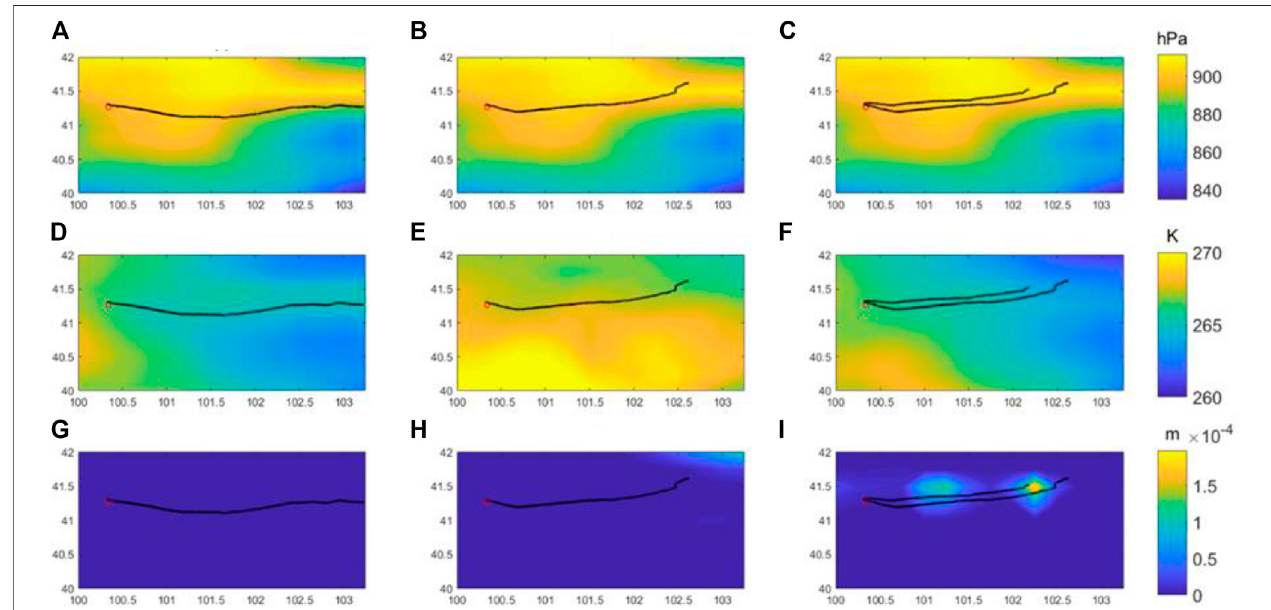
FIGURE 3 | The distribution of the meteorological elements around the release point of the sounding balloons from January 13 to 15, where (A – C) are surface air pressure, (D – F) are atmospheric temperature 2 m away from the ground, and (G – I) are total precipitation. The red circle represented the release position ofthe balloon, and the black point represented the horizontal trajectory of the balloon.